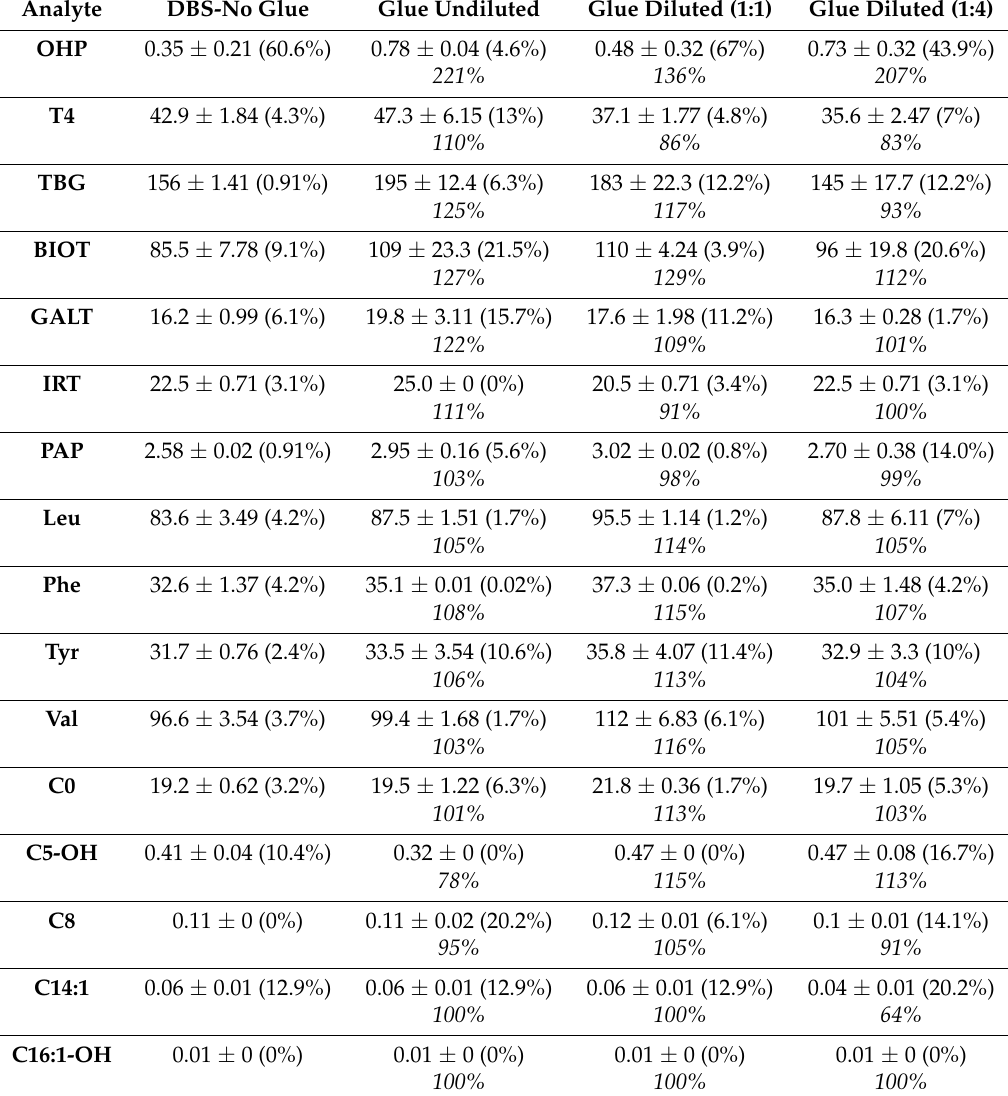
Table 4. Concentrations of analytes determined from DBSs prepared on filter paper with glue †